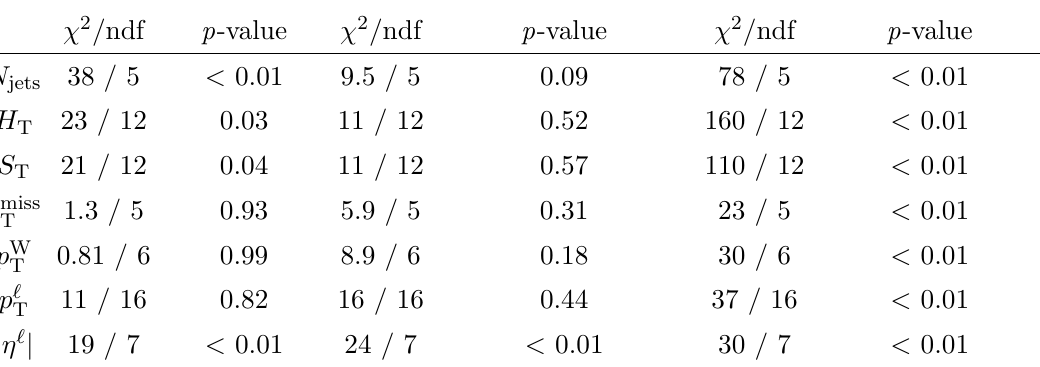
Table 2 . Results of a goodness-of-(cid:12)t test between the normalized cross sections in data and several models, with values given as (cid:31) 2 /number of degrees of freedom (ndf). decreases from 2.9/5 to 2.1/5. The e(cid:11)ects on the (cid:31) 2 for all other variables and models are small. The (cid:31) 2 does not change for the p ‘ unfolding without